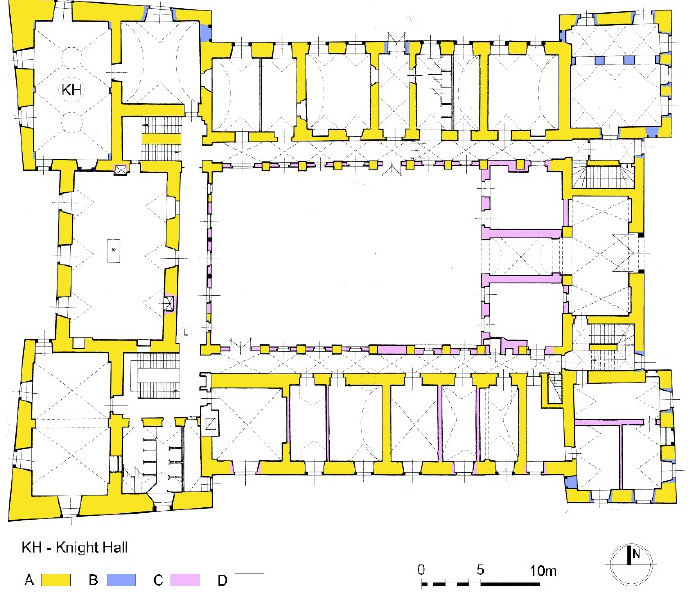
Figure 8. Pr ó szk ó w castle: ground floor plan with chronological stratification of the walls. Legend: A—Renaissance (approximately 1563); B—Baroque (1667–86); C—1881; D—walls unknown and